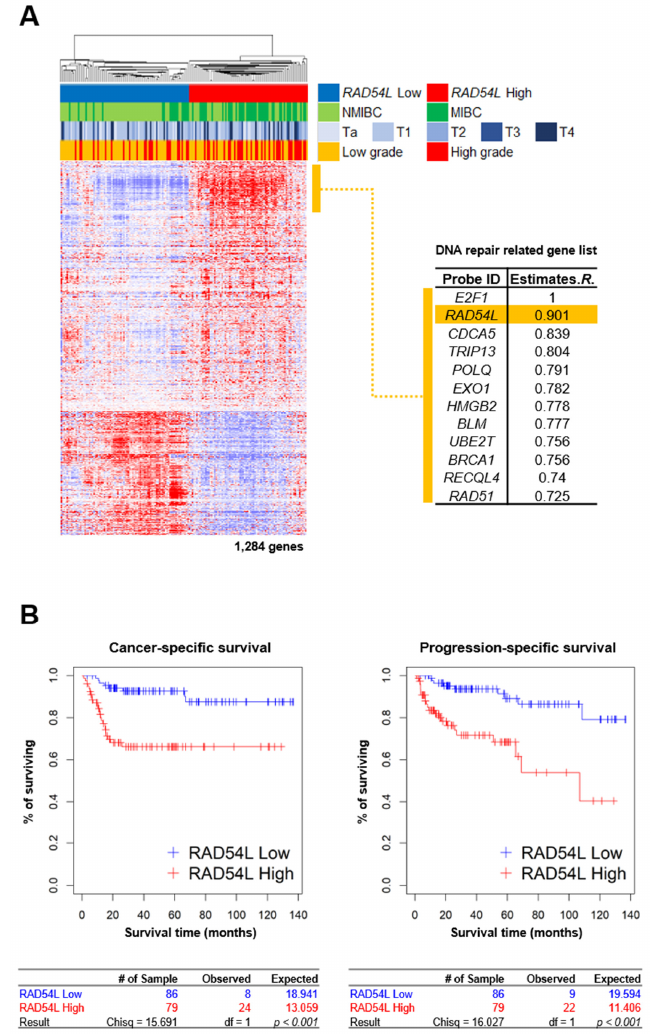
Figure 1. Gene expression patterns of co-expressed gene set of RAD54L, cancer-specific survival, and progression-specific survival of BLC patients in Korean cohort. ( A ) Expression patterns of RAD54L gene and its correlated genes. A total of 1,284 genes with expression patterns highly correlated with RAD54L were selected for cluster analysis. ( B ) Cancer-specific survival (CSS) and progression-specific survival (PSS) analyses according to RAD54L expression in BLC patients. BLC patients were divided into two subgroups: low RAD54L expression (Green) and high RAD54L expression (Blue).